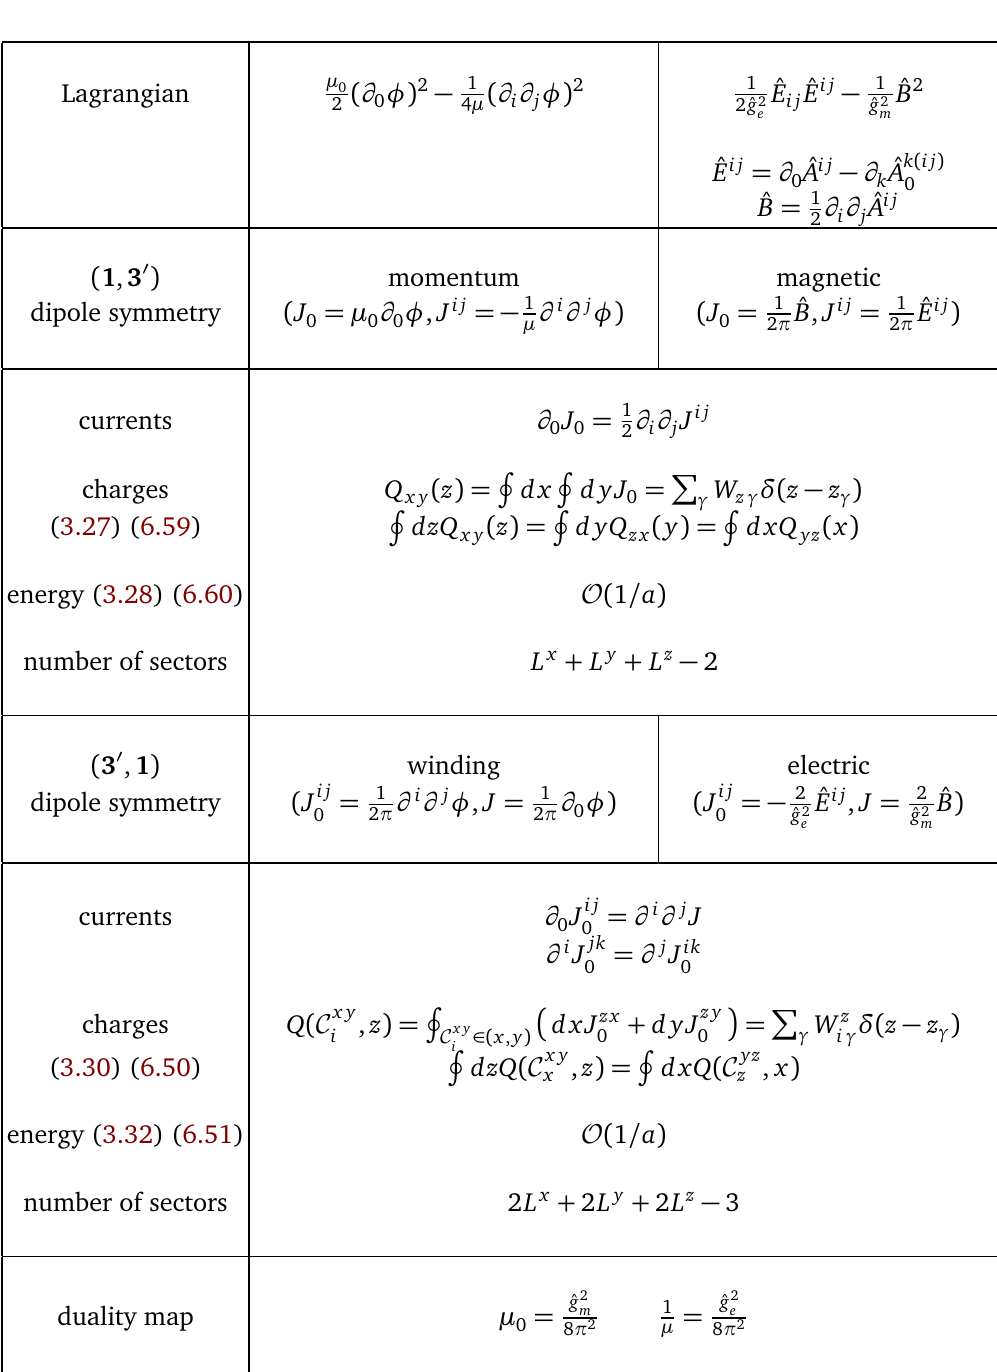
Table 4: Global symmetries of the U ( 1 ) tensor gauge theory ˆ A and its dual φ . Here C ij is a curve on the i j plane that wraps around the i cycle once but not the j cy- i cle. Above we have only shown charges for some directions, while the others admit similar